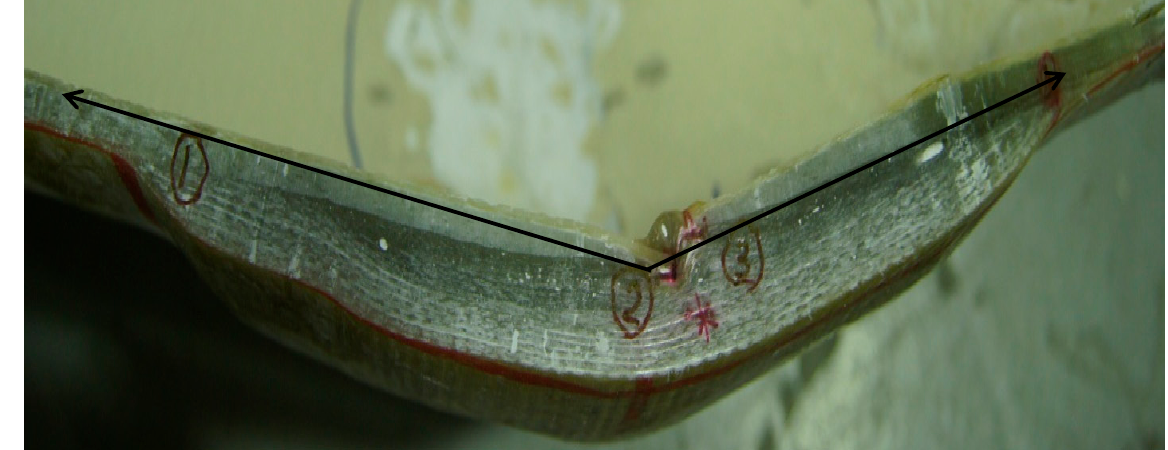
Figure 14. Thickness variation of composite elbow.